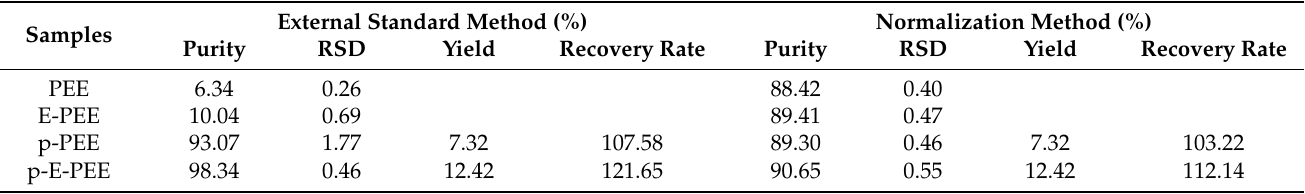
Table 2. The purity, yield, and recovery yield of all